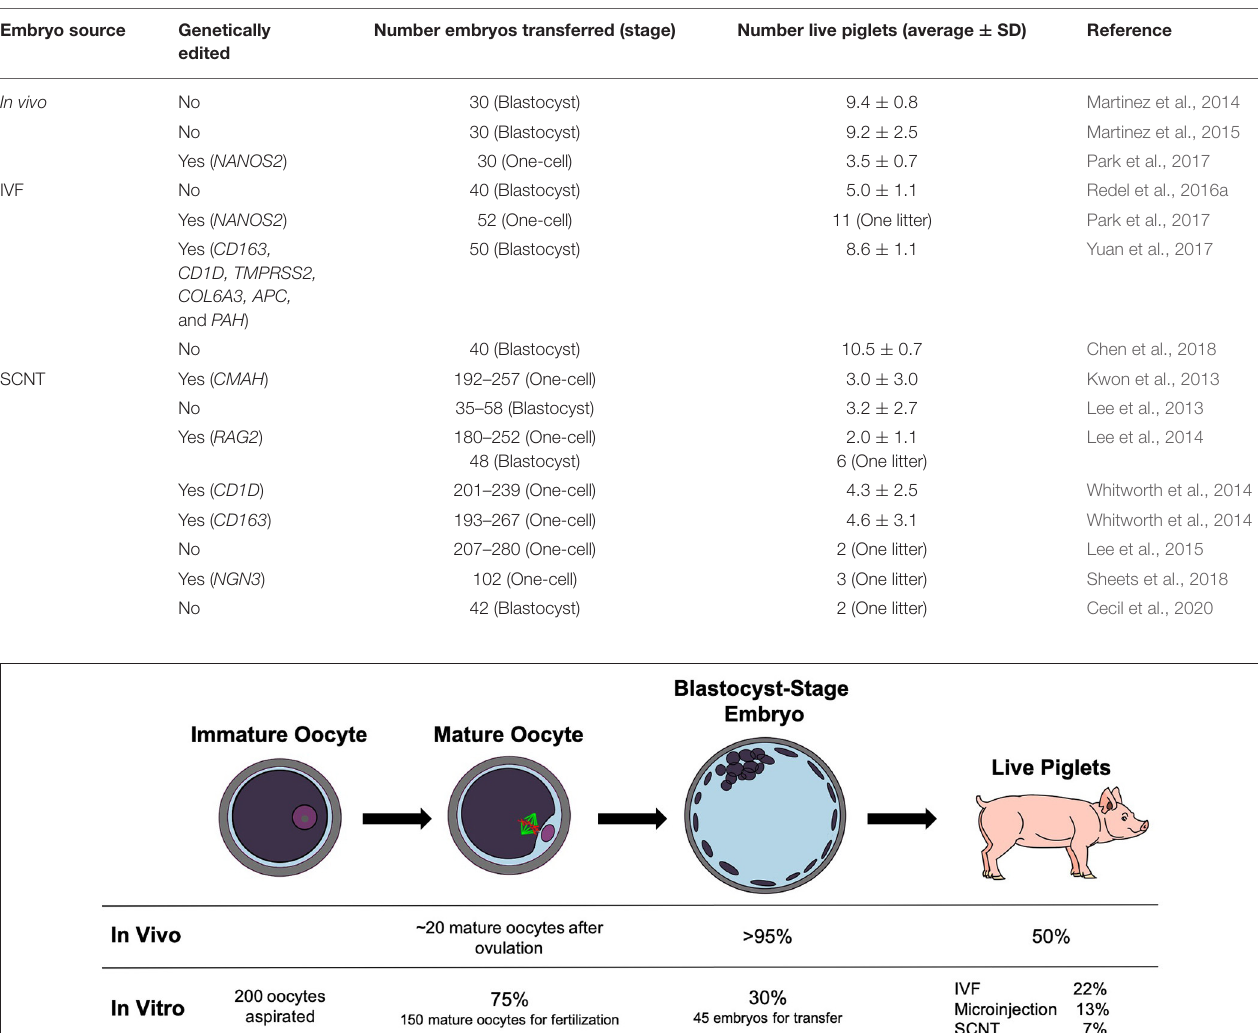
TABLE 1 | Live-born litter sizes after surgical transfer of embryos from different sources. Embryo source